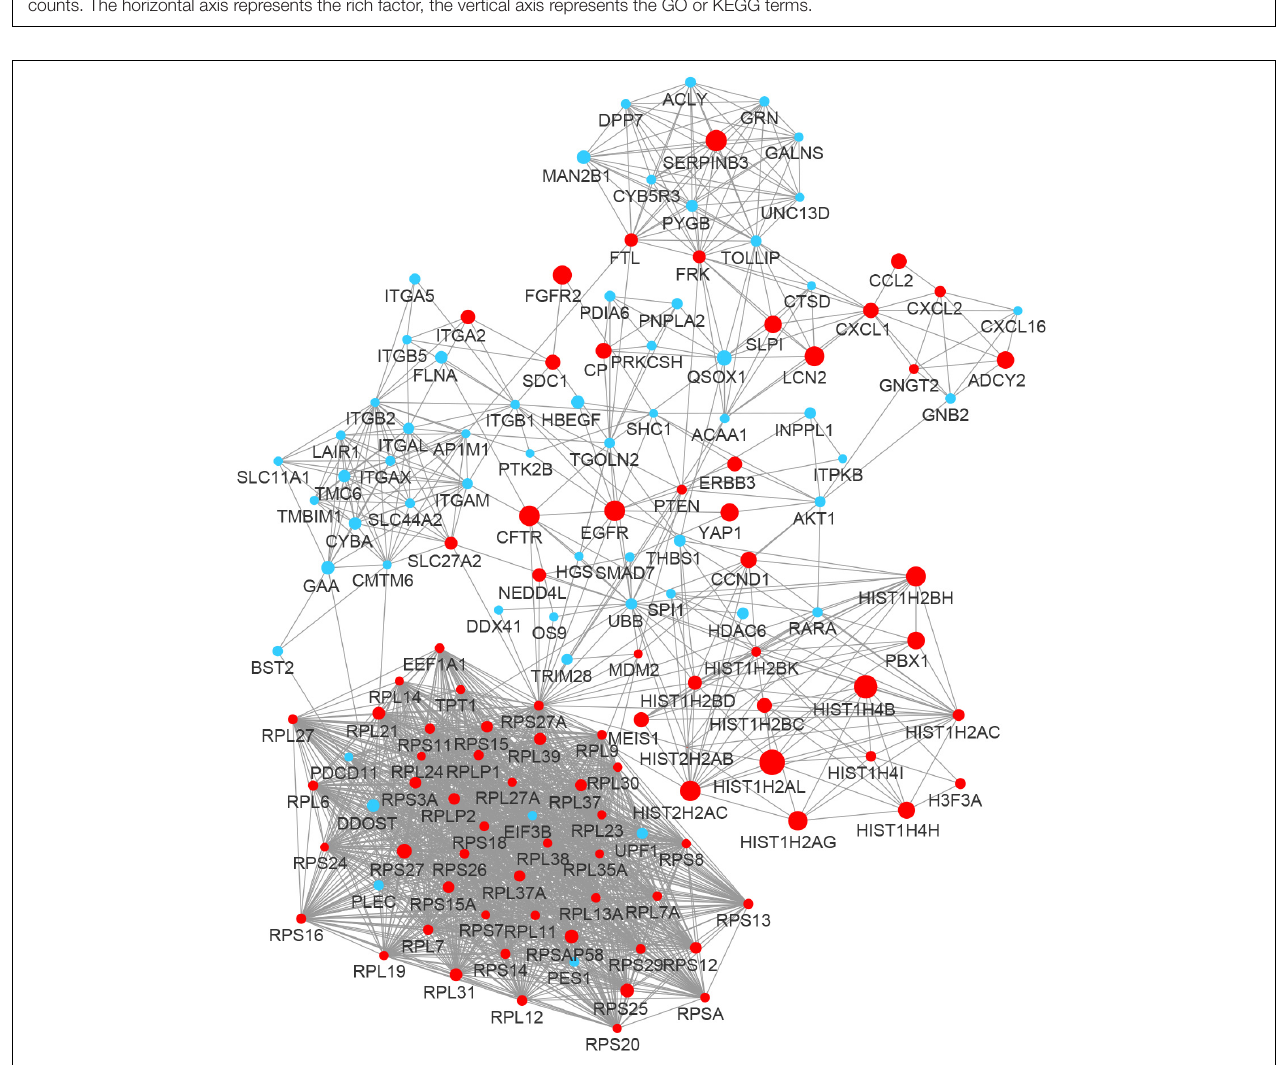
FIGURE 3 | The PPI network of the DEGs in BALF of COVID-19 patients. The nodes representing up-regulated DEGs are shown as red circles and the down-regulated DEGs are presented as blue circles. The sizes of the nodes are illustrated from small to big in ascending order of |Log2 (FC)|.